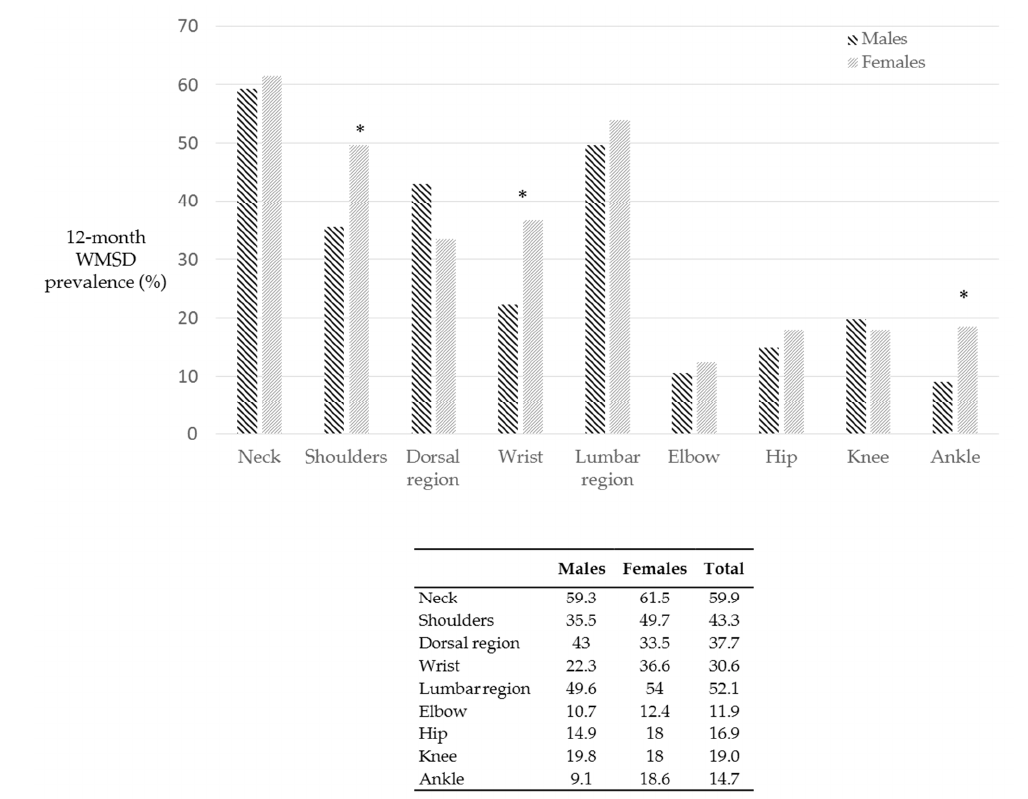
Int. J. Environ. Res. Public Health 2021 , 18 , x Figure 8. WMSD experienced in the last 12 months according to gender variables. Females showed a higher presence of WMSD in most of the body regions. Asterisks indicate statistically significant differences ( p < 0.05). Figure 9 reports WMSD that impeded to perform routinely activities in the last 12 months. Females showed higher percentages than males in 8 out of 9 body areas. Lumbar regions, shoulders and neck were the most affected areas. In particular, percentages of WMSD in the shoulder region were significantly higher in females than males ( p = 0.028).